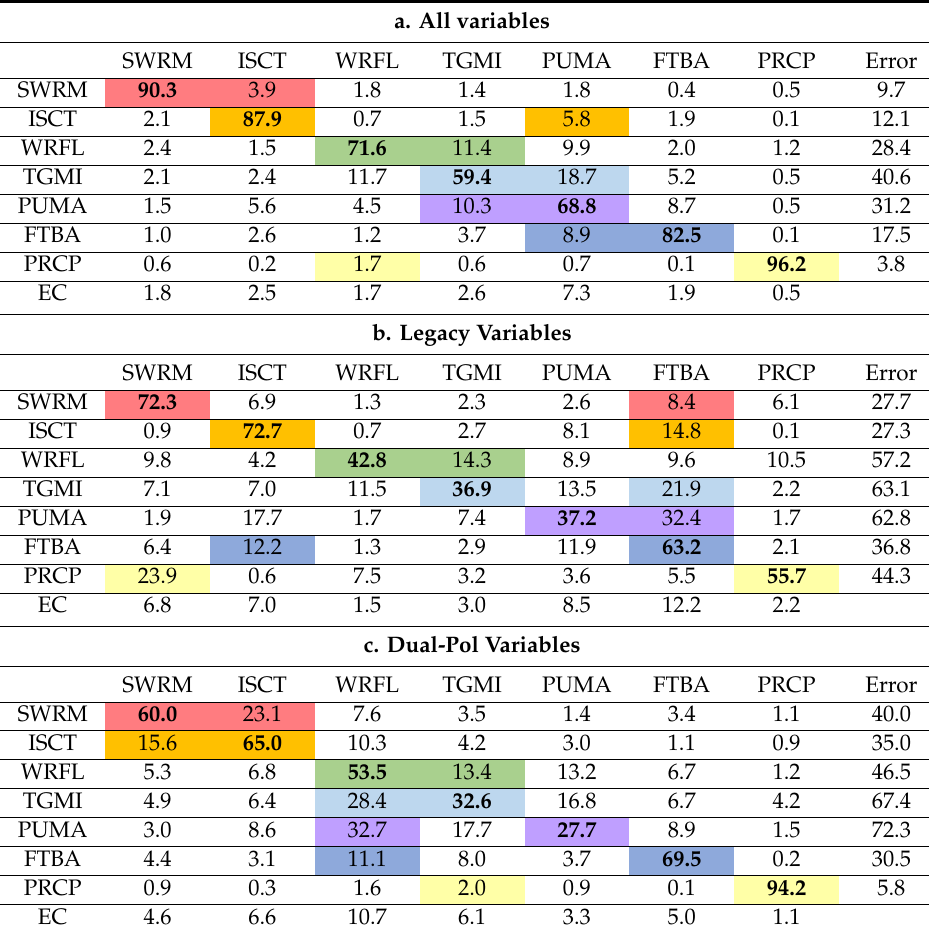
Table 5. Seven-class multinomial RF model results showing classification of validated scatterers in the non-training set. Values are percent of the total out-of-bag samples assigned to that class. Percent classification error is summed to the right. Error contribution (EC) is the median percent error contributed by that class across all classifications. Results are given for models based on three di ff erent variable combinations; (a) all six variables, (b) three legacy variables (Z H , Vr, σ V ), and (c) three polarimetry variables (Z DR , ρ HV , Φ DP ). For each model, the true positive (in bold) and highest false positive results are highlighted by the same